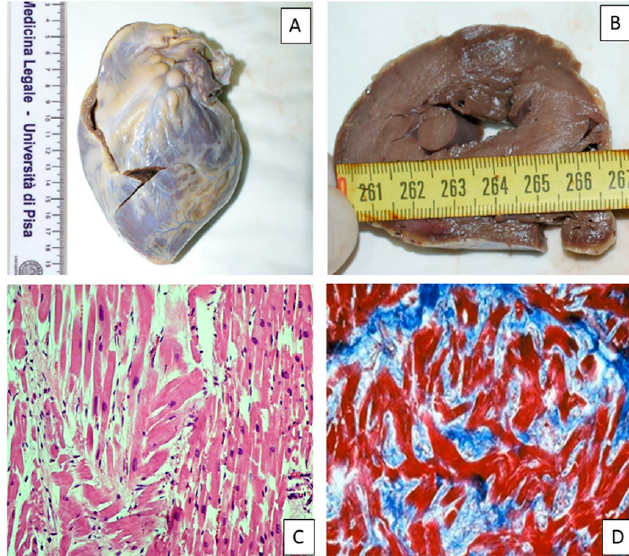
Figure 7. Pathology findings in a case of an HCM patient 22 years old with sudden death. Gross